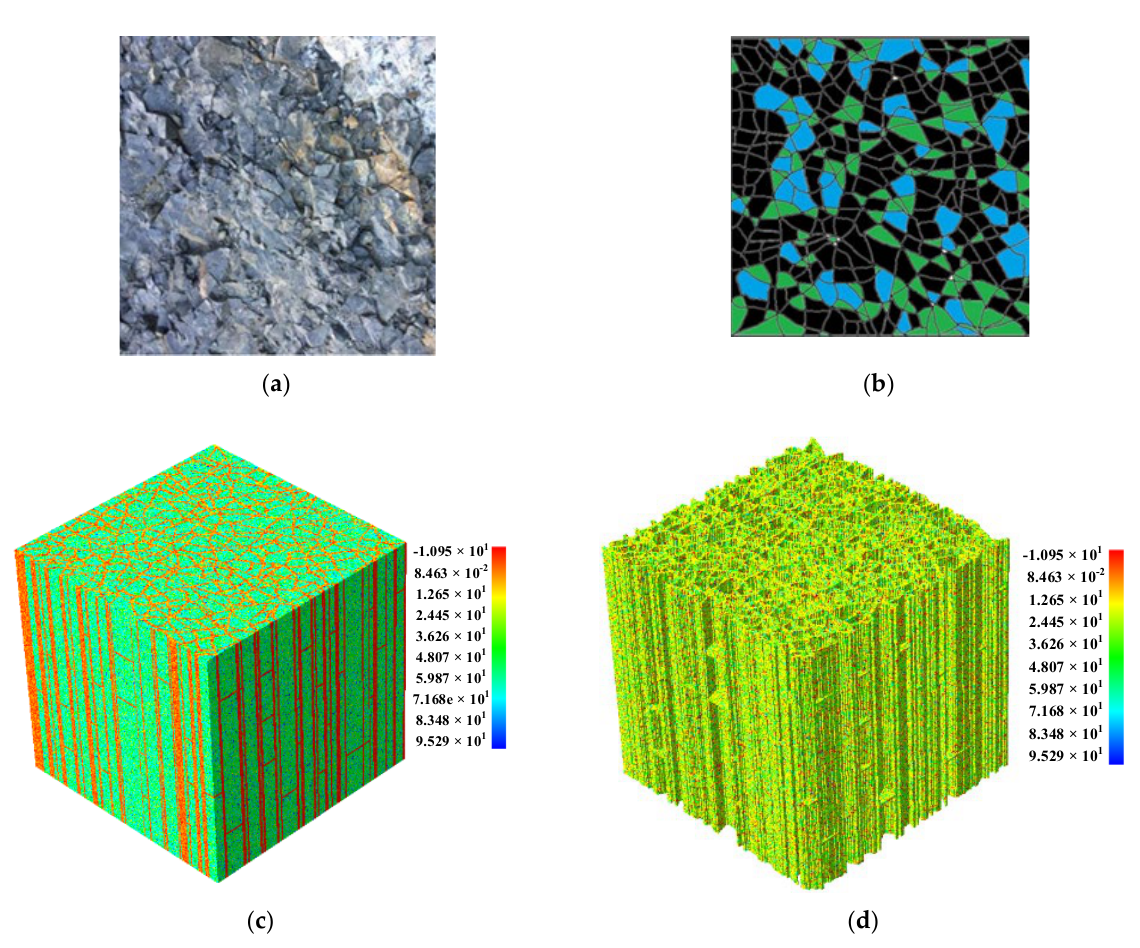
Figure 12. Configurations of columnar jointed basalt. ( a , b ) Structural descriptions of columnar jointed basalt in transverse sections [35]. ( c ) A numerical model for the columnar jointed basalt. ( d ) The spatial shape of the joints is characterized. Table 2. Material properties of the CJRM FE model [58].